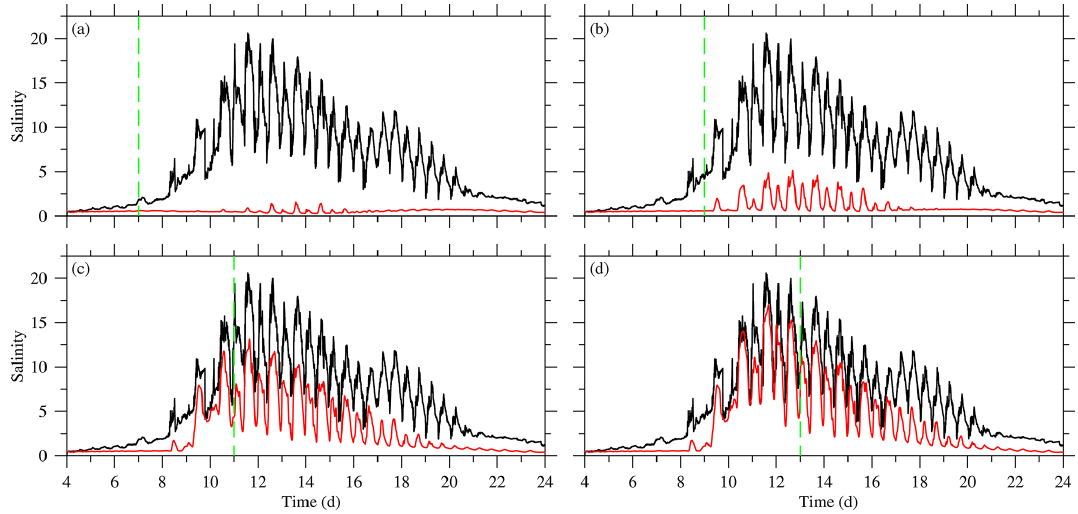
Figure 15. Temporal variation in observed (black line) and modeled (red line) salinity at Baozhen station from 4 to 24 February 2014. The green dashed lines indicate the time before the wind was realistic and after it was set to 5ms − 1